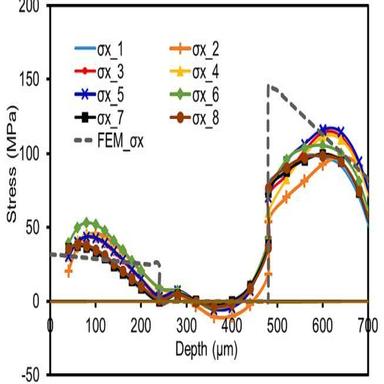
Validation of the values obtained for the residual stress component of σx. The material probed is the GFRP/steel/GFRP laminate. See text for details.